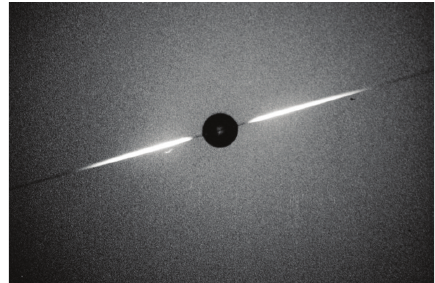
Figure 1: Digitized frame of 16mm film from the droplet view camera.